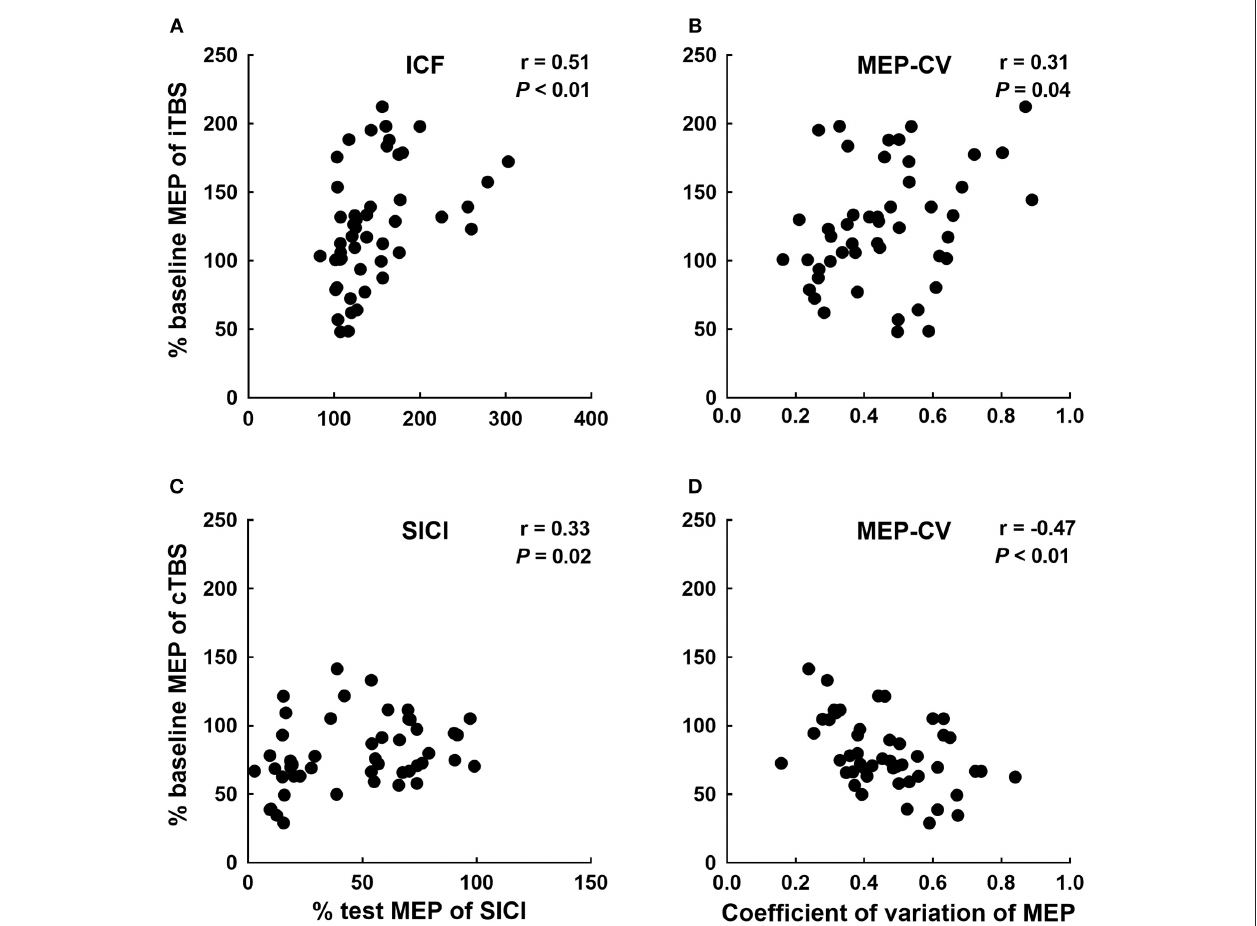
FIGURE 4 | Significant correlations between each TBS response and neurophysiological factors. Correlations between the iTBS response (% of baseline MEP at Post-0) and ICF (A) and MEP-CV (B) at Pre. The correlations between the cTBS response (% of baseline MEP at Post-0) and SICI (C) and MEP-CV (D) at